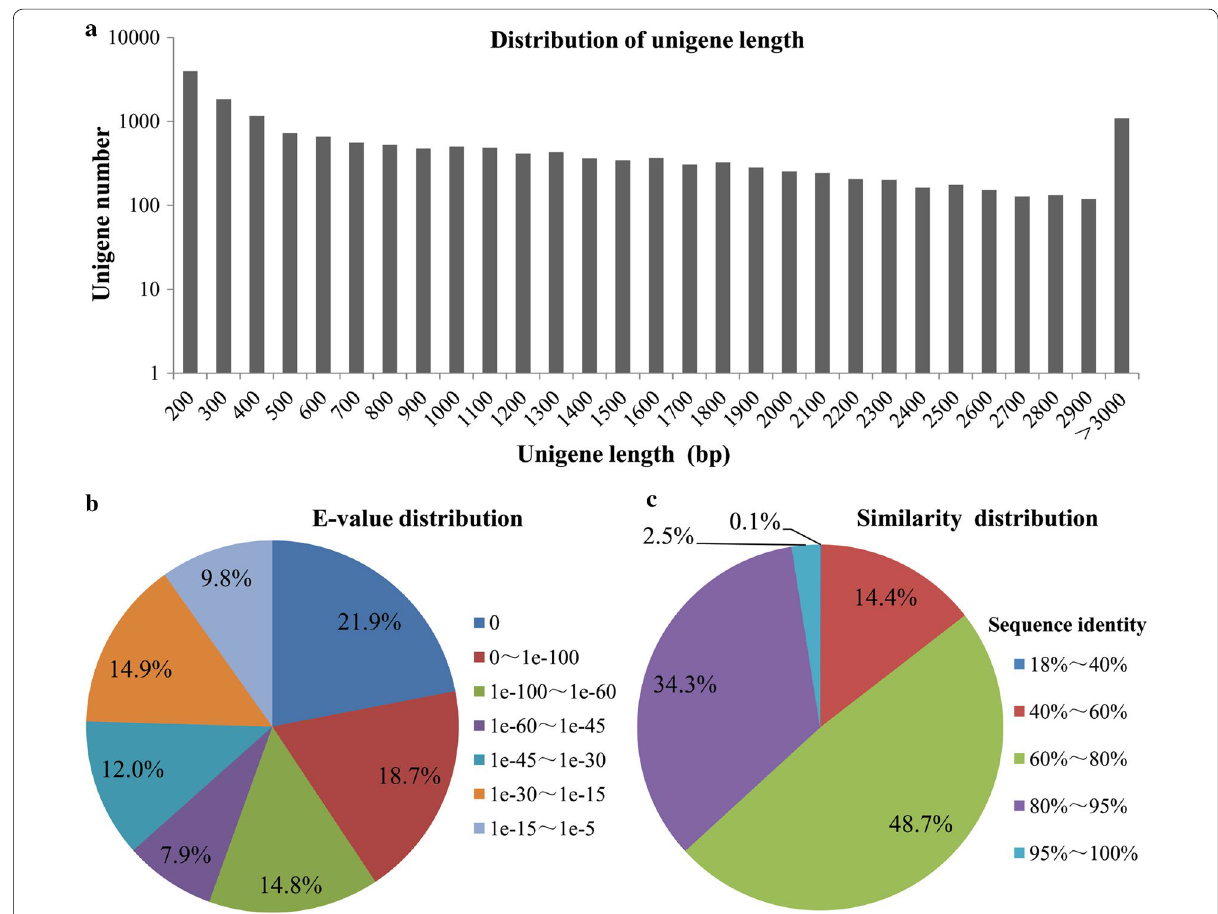
Fig. 1 mRNA‑seq and de novo assembly of C. cladosporioides MD2 transcriptome. a Distribution of unigene length. b E‑value distribution of BLAST hits for each unique sequence against the Nr database. c Similarity distribution of the top BLAST hits for each sequence against the Nr